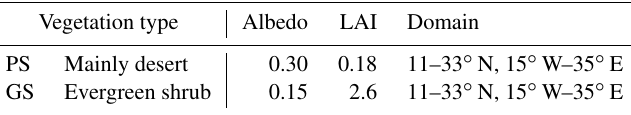
Table 2. Albedo and leaf area index (LAI) for desert, evergreen shrub, and the domain over which the vegetation changes are applied in each